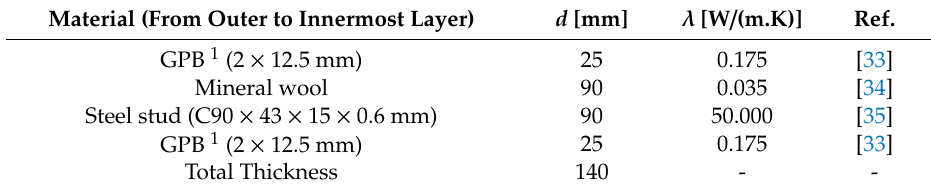
Figure 2. Cross-section of an interior LSF reference partition wall modeled on THERM software. Table 1. Materials, thicknesses ( d ) and thermal conductivities ( λ ) of the LSF interior reference partition wall.